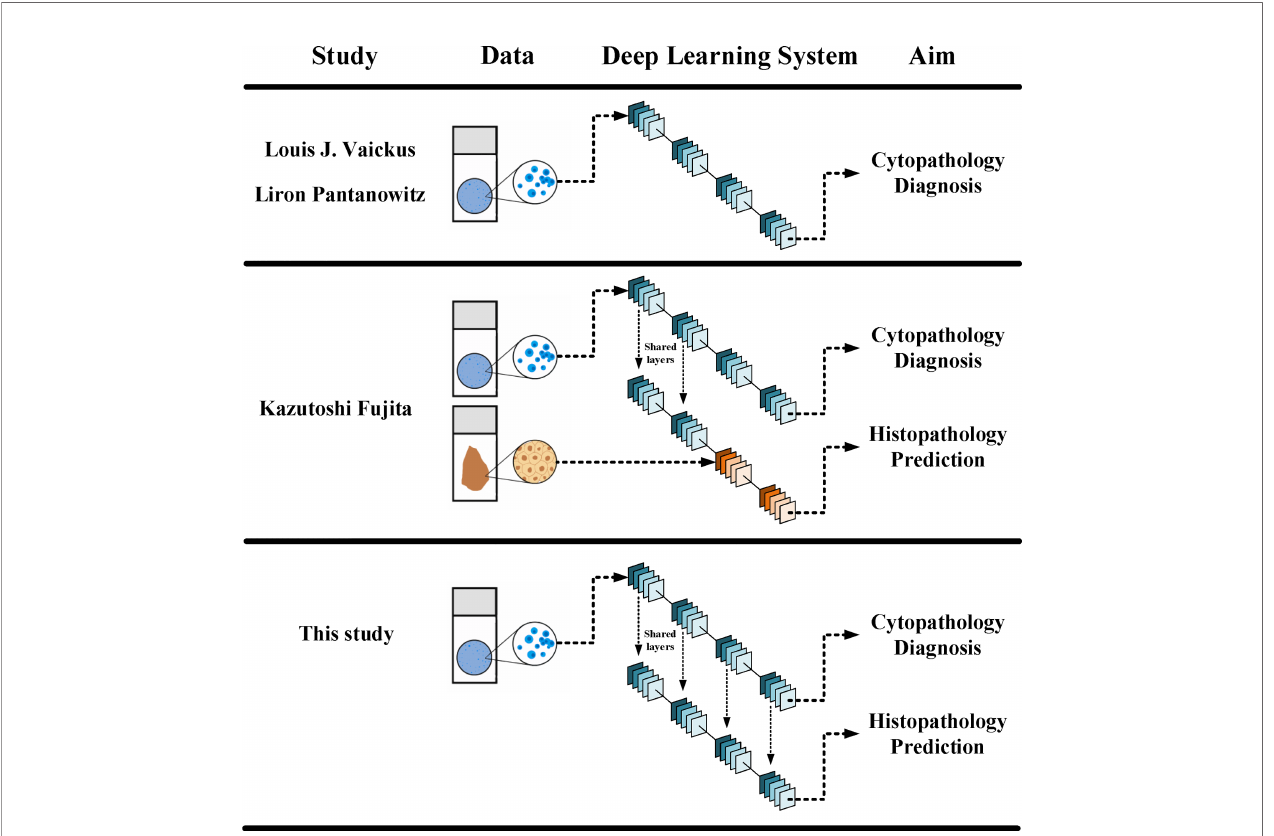
FIGURE 6 | Different designs in between different DLSs. The current DLS could make both cytopathological diagnosis and histopathological prediction, yet it did not need histopathological data in its